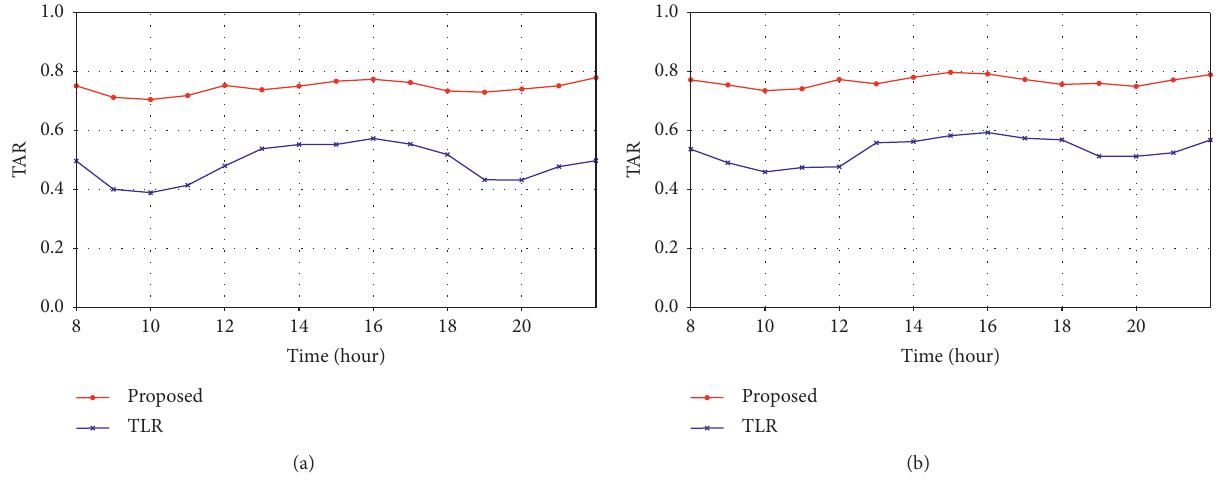
Figure 7: Model performance comparison. (a) The performance on weekdays. (b) The performance on